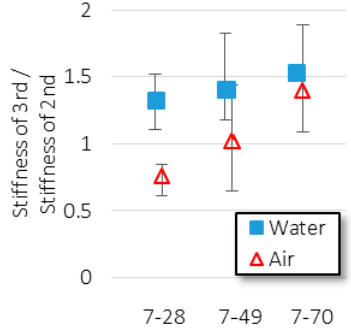
Figure 13. Ratios between flexural stiffness of 3rd loading and that of 2nd loading (different healing